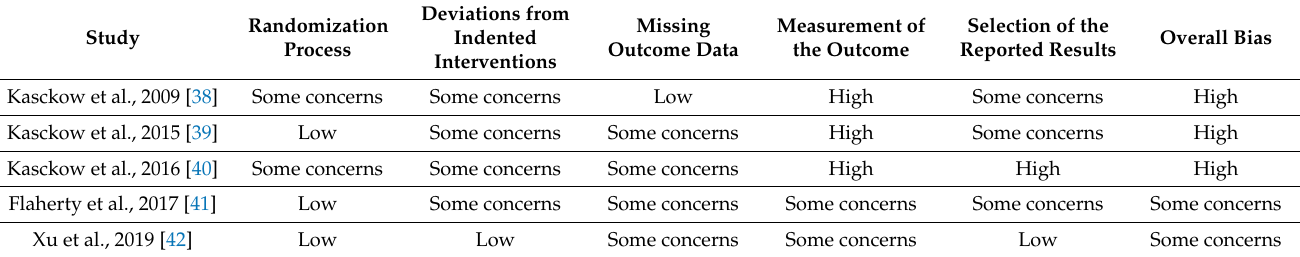
Table 2. Risk of bias assessment for each article employing the Cochrane Collaboration’s tool for assessing risk of